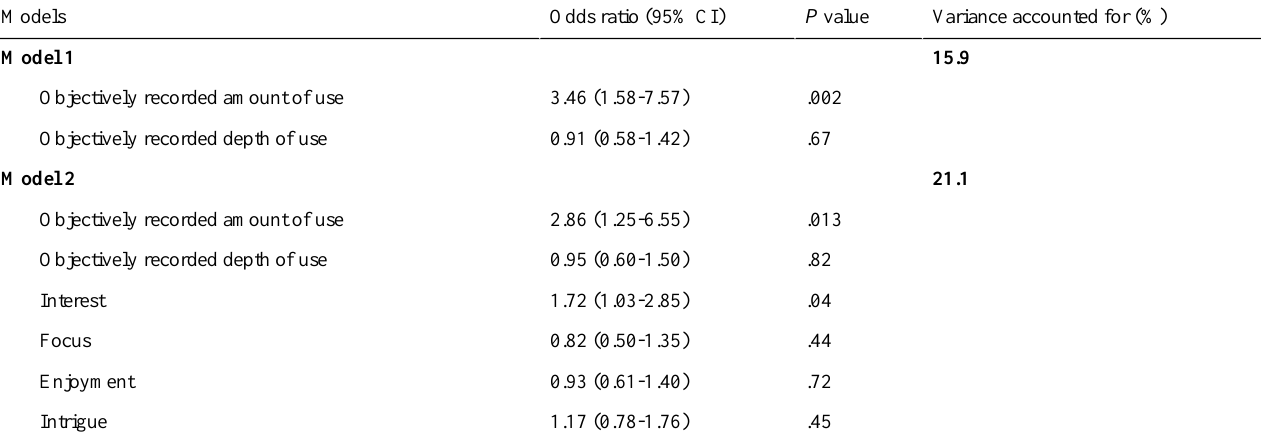
Table 6. Odds ratios for the associations between the predictor variables and future behavioral